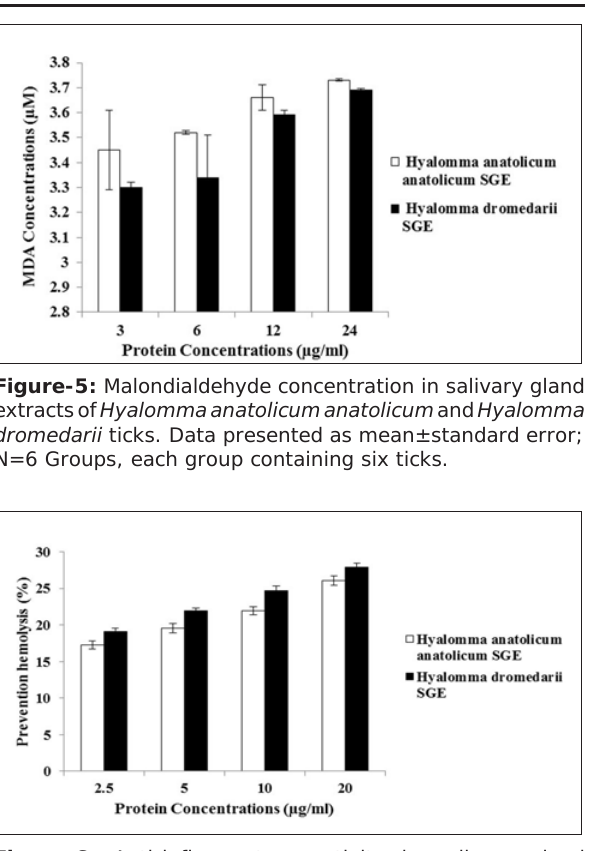
Figure-6: Anti-inflammatory activity in salivary gland extracts of Hyalomma anatolicum anatolicum and Hyalomma dromedarii ticks. Data presented as mean±standard error; N=6 Groups, each group containing six